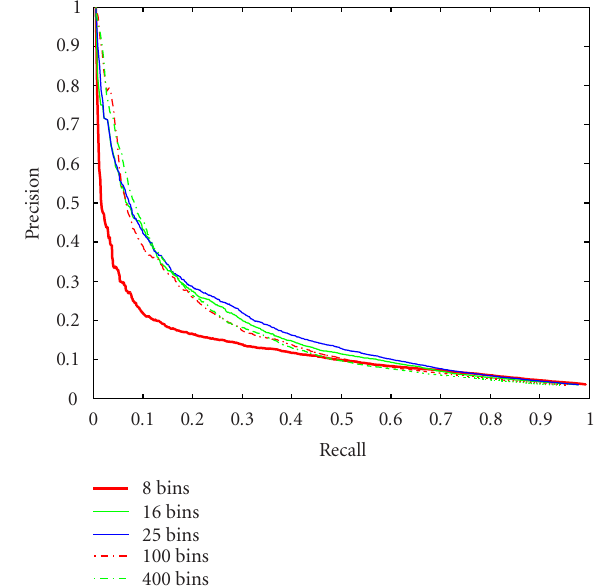
Figure 1: Precision/recall curves for di ff erent numbers of classes (sunset category).